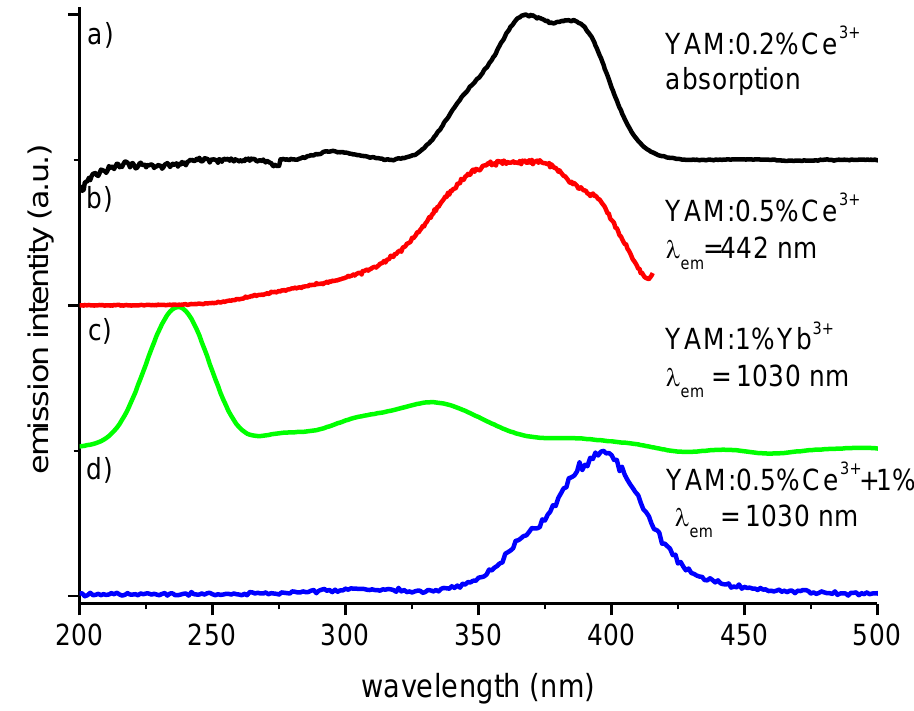
Figure 4. Absorption and excitation spectrum of cerium activated YAM sample (a,b), the excitation spectrum of Yb 3+ emission of Yb 3+ doped YAM sample in the UV/VIS range (c), the excitation spectrum of Yb 3+ emission at 1030 nm of Ce 3+ -Yb 3+ co-doped sample (d).